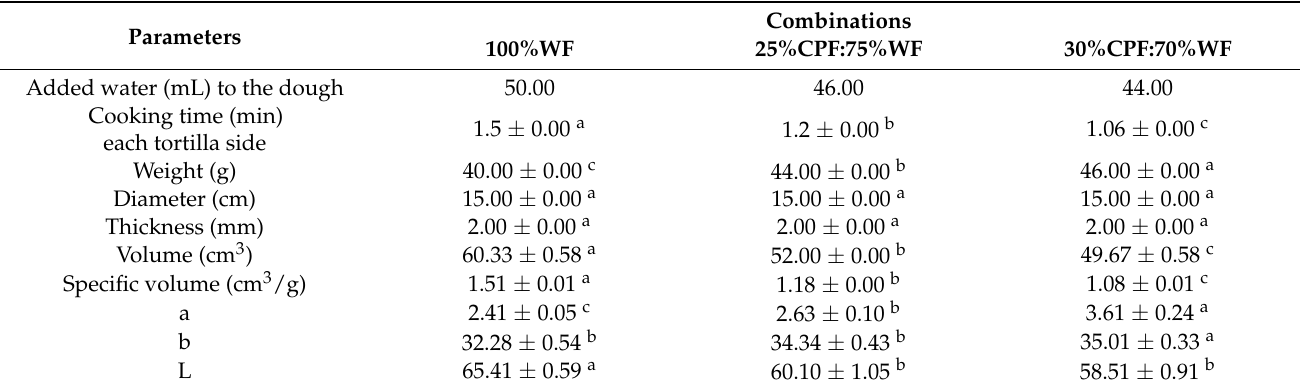
Table 5. Technological quality of durum wheat tortilla and fortified durum wheat tortillas with chickpea